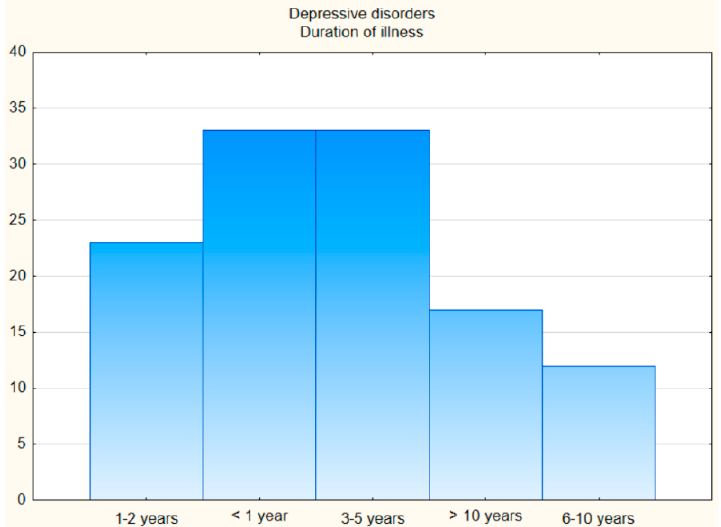
Figure 1. The duration of illness.